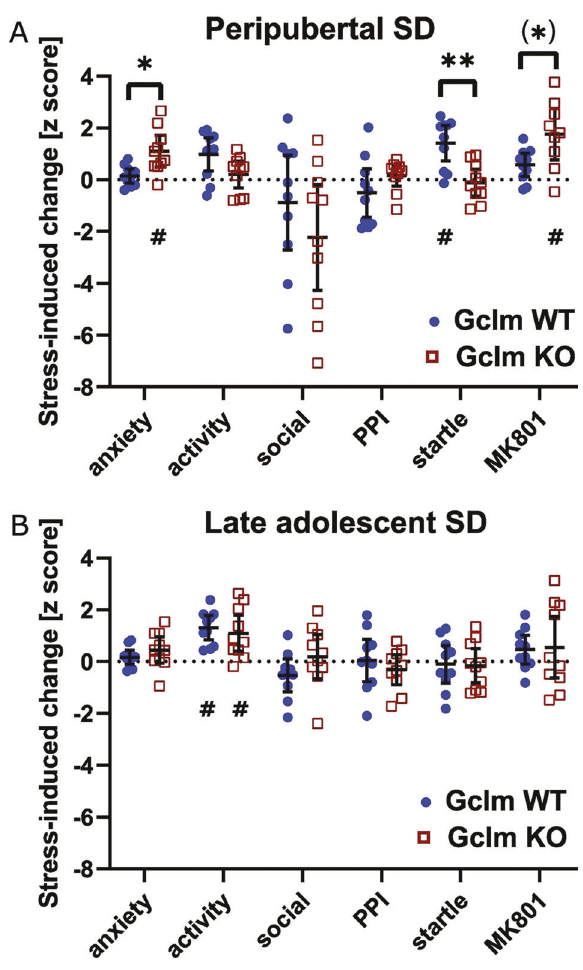
Fig. 4 Stress-induced long-lasting changes in anxiety-like beha- vior in anxiogenic environment, exploratory activity in novel environments, social interaction, pre-pulse inhibition (PPI), acoustic startle re fl ex, and MK-801-induced locomotor activity in WT and Gclm-KO mice. The behavioral changes ( z scores) induced by peripubertal SD stress ( A ), but not late adolescent SD stress ( B ), are signi fi cantly different in both genotypes. Data are presented with the mean and 95% con fi dence interval. * indicates differences between WT and KO mice: * p < 0.05, ** p < 0.01, (*) did not survive Holm Bonferroni for multiple comparisons. # Indicates that stress signi fi cantly affected one behavioral dimension ( p < 0.05, sign